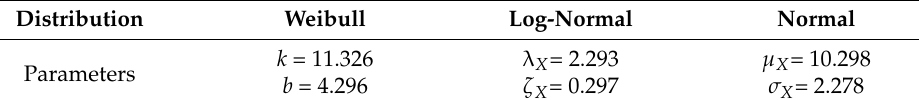
Table 5. Characteristics of distributions.